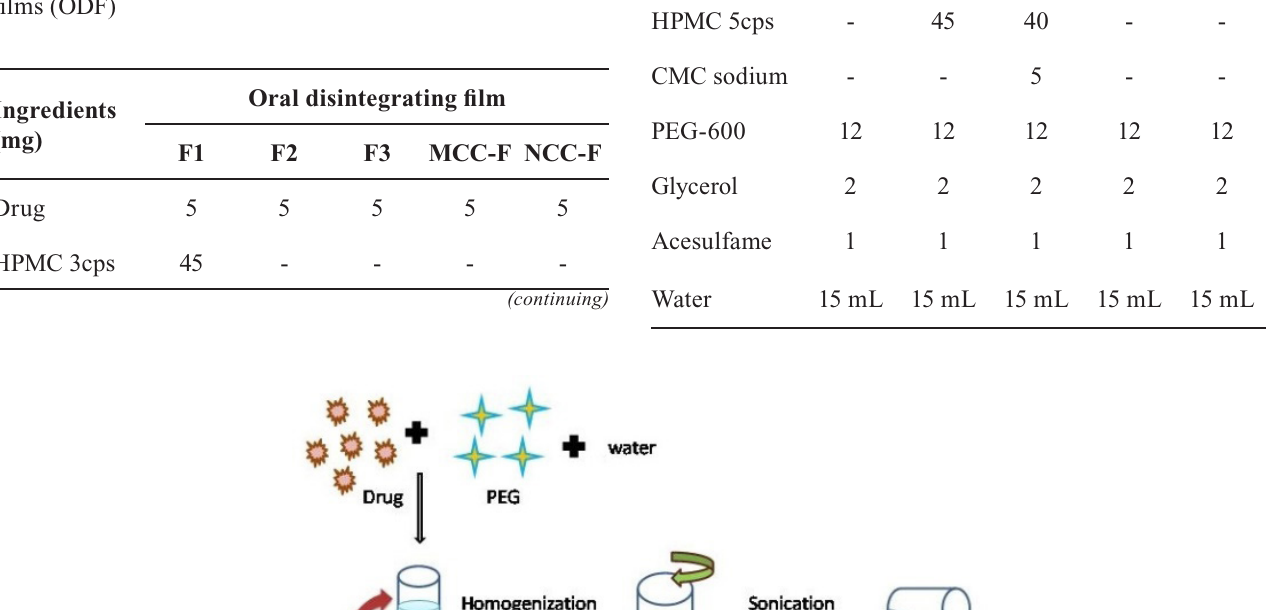
TABLE I - F ormulation composition for oral disintegrating films (ODF)